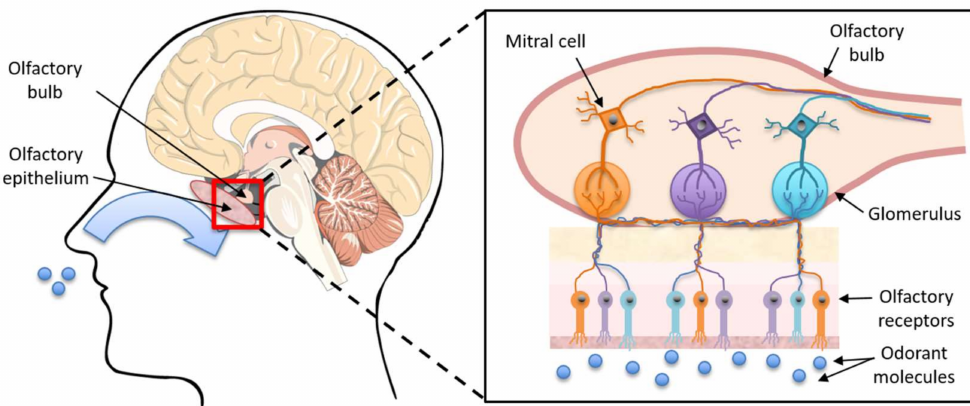
Figure 3. The olfactory